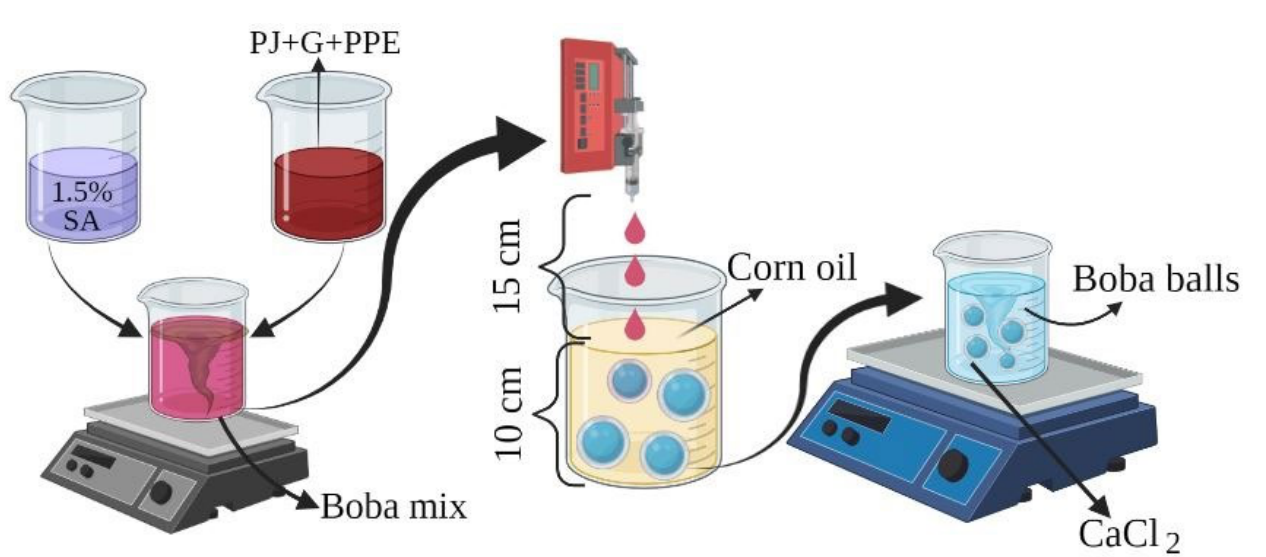
Figure 1. The schematic illustration of “Boba balls” production enriched with pomegranate peel extract (PPE).